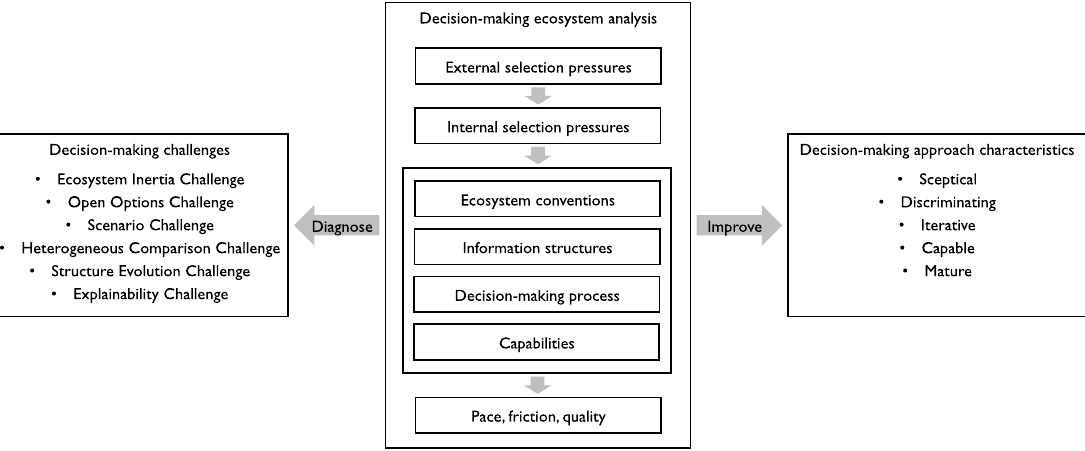
Figure 5. Information evolution analysis tools will enable the underlying issues that drive the decision-making challenges to be diagnosed and improvements